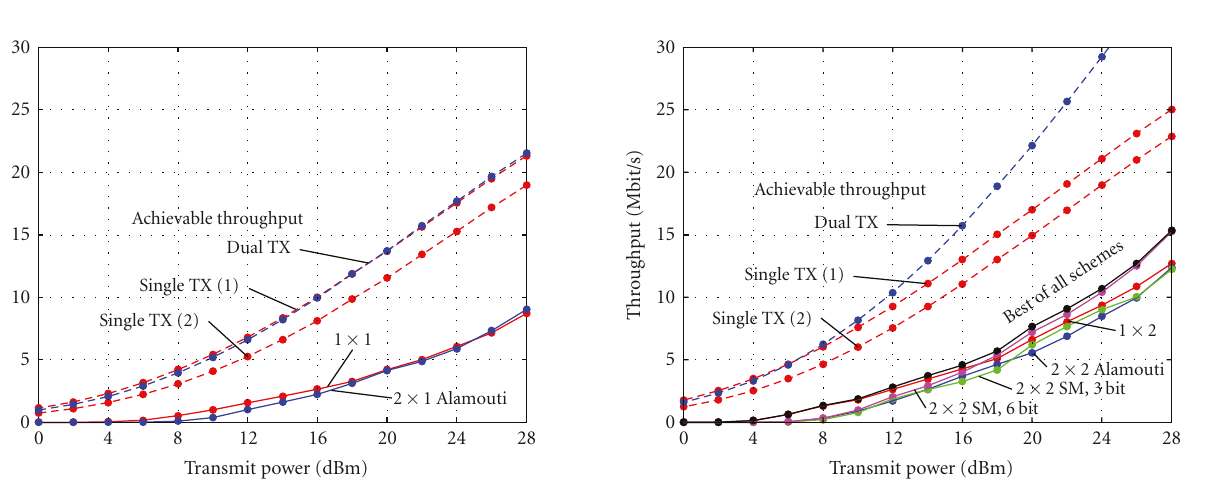
Figure 6: Scenario 1, measured (solid) and achievable (dashed) data throughput in the NLOS outdoor-to-indoor scenario using two receive antennas. The largest transmit power corresponds to a receive SNR of about 22 dB.